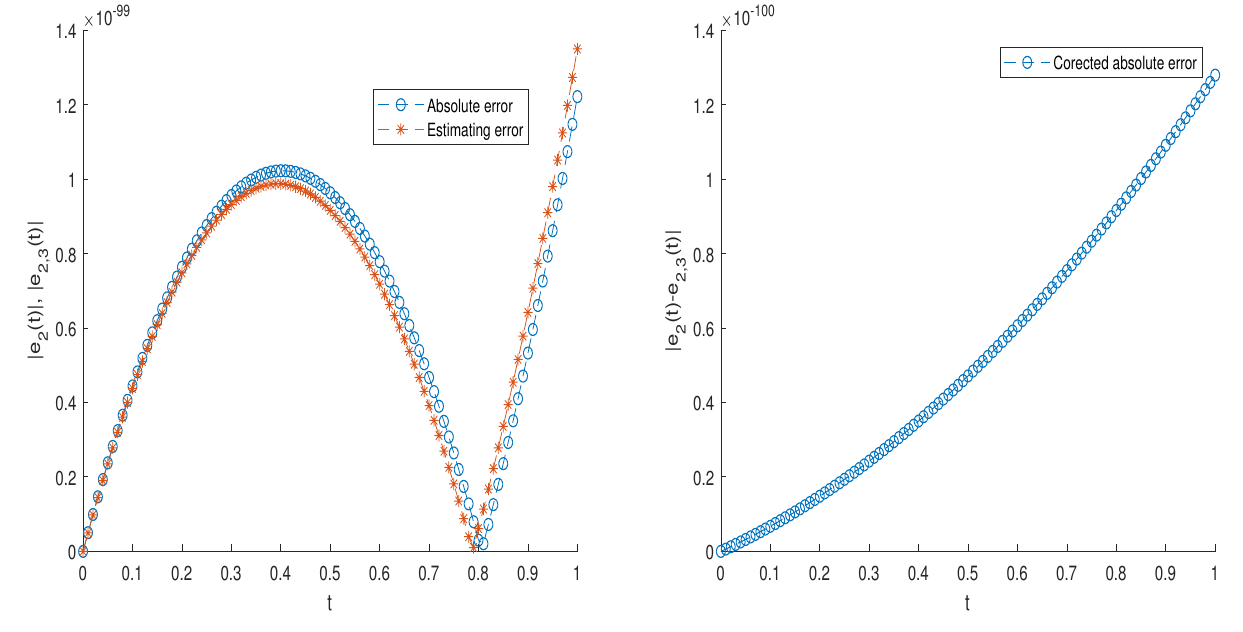
Figure 1. The error, its estimations and the corrected error, for Example 1 and ( N , M ) = ( 2,3 )